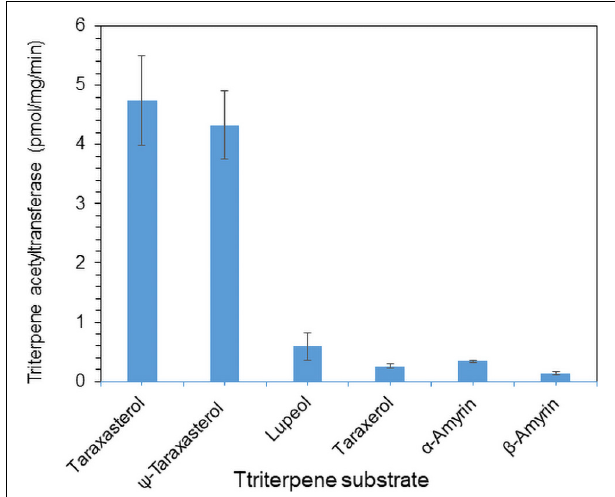
FIGURE 6 | In vitro conversion rate of triterpenes into triterpene acetates catalyzed by the LsTAT1 enzyme. The enzyme activities are expressed as relative values of the conversion of triterpenes into triterpene acetates, and these values were analyzed by Gas chromatography–mass spectrometry (GC/MS) with selective ion monitoring. The values represent the means ( n = 5) ±